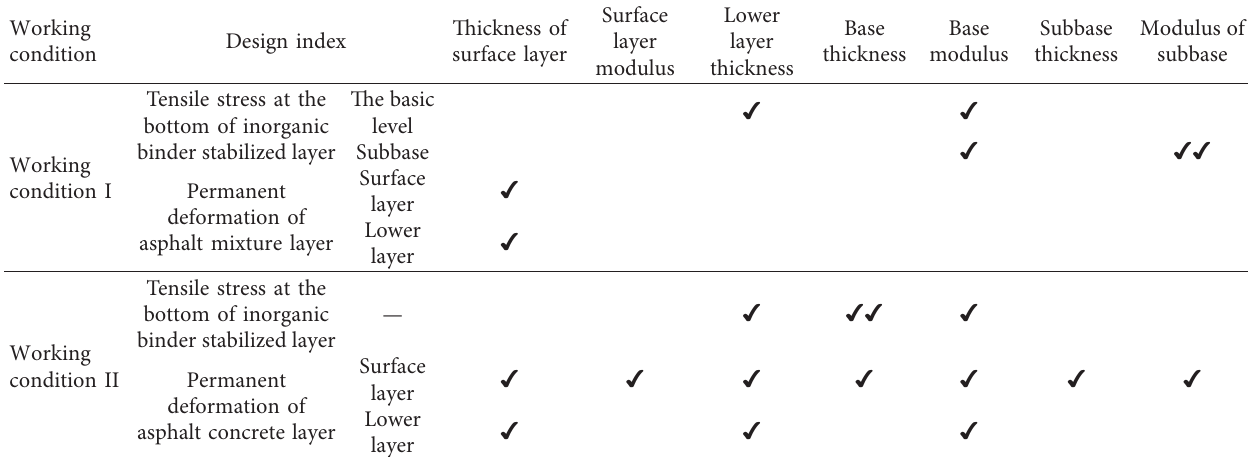
Table 5: The influence degree of control indicators.